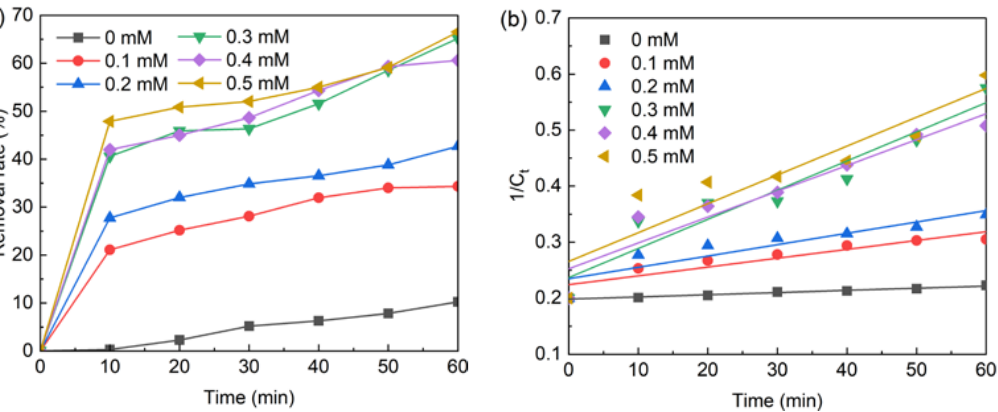
Figure 2. ( a ) The effect of PS dose on BPA removal; ( b ) The kinetic of BPA degradation by PS dosage. Conditions: [PS] = 0.1–0.5 mM, T = 20 °C, pH = 6.8, [nFe 3 O 4 ] = 0.l g/L, [BPA] = 5 mg/L. Table 2. The kinetic parameters of BPA degradation by PS dosage. Initial Substrate Concentration